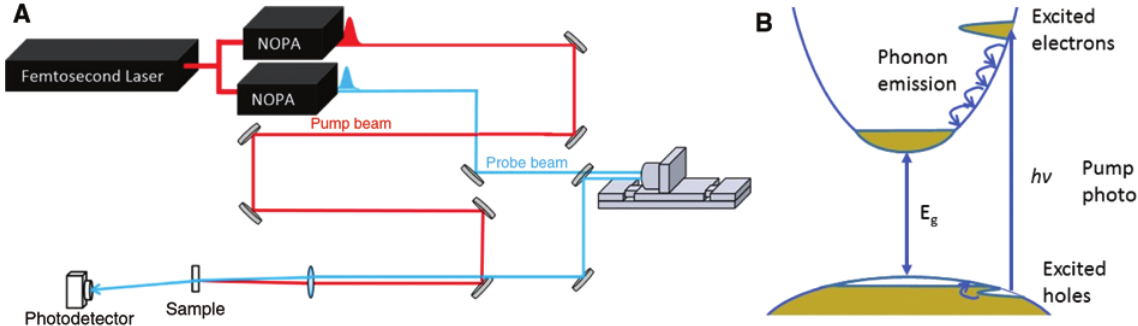
Figure 8: Pump-probe spectroscopy. (A) Experimental pump-probe setup enabling the study of coherent phonons in the time domain. (B) Photoinduced dynamics of electrons and phonons in semiconductors. Adapted from